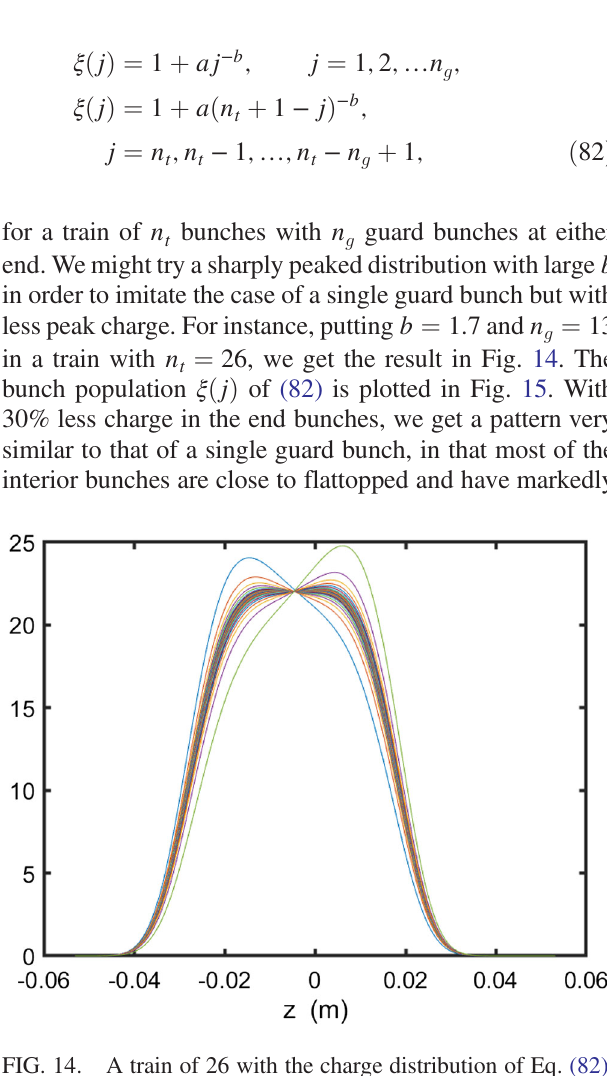
FIG. 13. The 18 normal bunches in the middle of the train, each with ξ ¼ 1 .